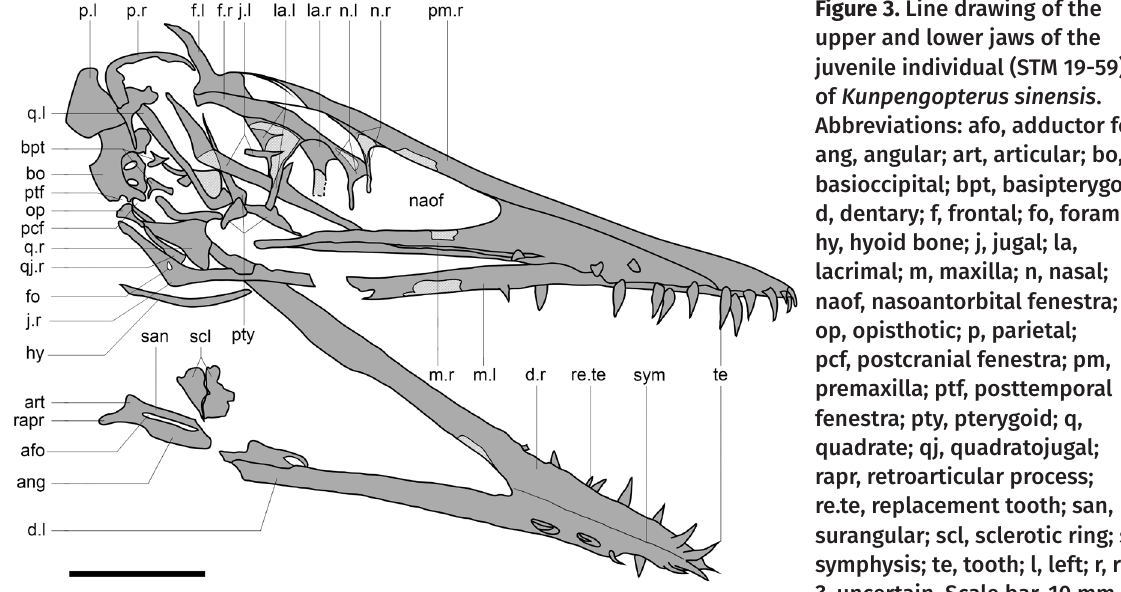
Figure 3. Line drawing of the upper and lower jaws of the juvenile individual (STM 19-59) of Kunpengopterus sinensis